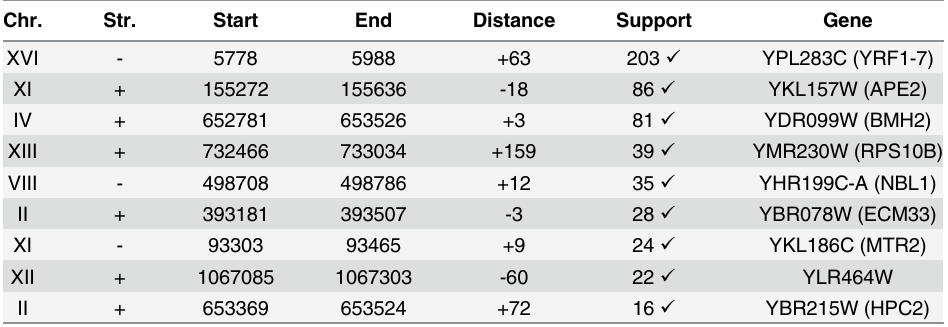
Table 4. Alternative 3 ’ splice sites preserving the reading